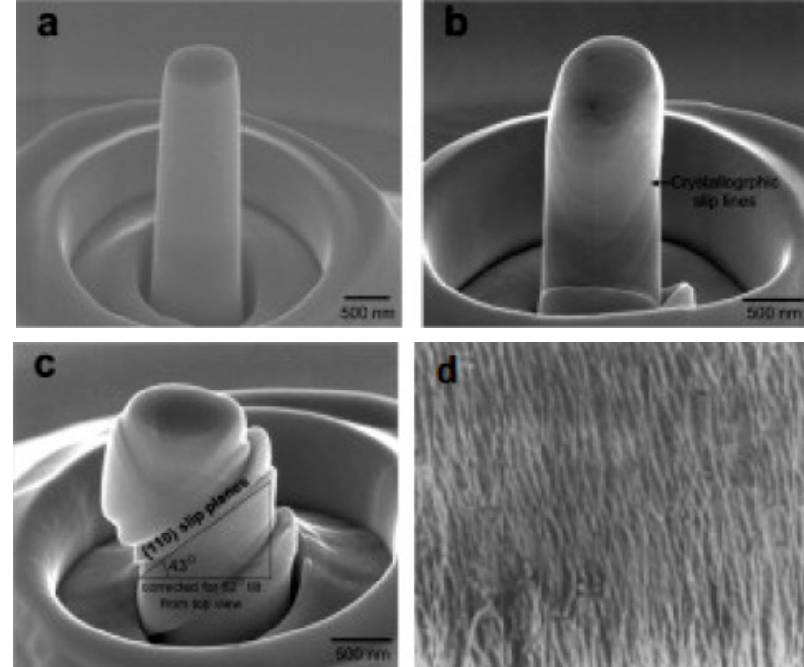
Fig. 26. SEM images of (a) nanopillar before compression, (b and c) severely compressed (up to ~30% true strain) nanopillars including pronounced crystallographic slip lines [49] d) Wavy lines in (100) surface of bulk Nb single crystal after 42% shear strain in compression, in which traces of both active slip planes are parallel [247]. Reprinted with permission from Kim JY, Jang DC, Greer JR. 2009. Insight into the deformation behavior of niobium single crystals under uniaxial compression and tension at the nanoscale. Scripta Materialia 61, [49]: (c) 2009 Elsevier